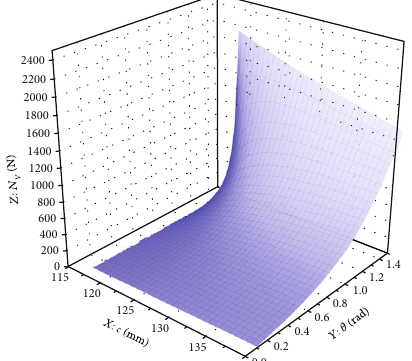
c , and θ relationship. V ,